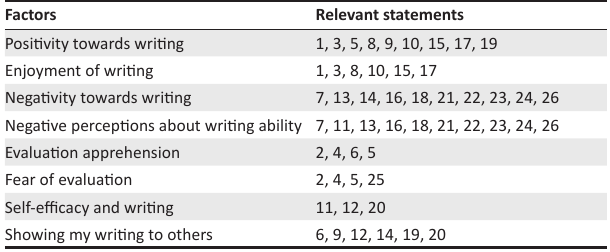
TABLE 5: Factors comparison of the DM-WAT and Cornwell and